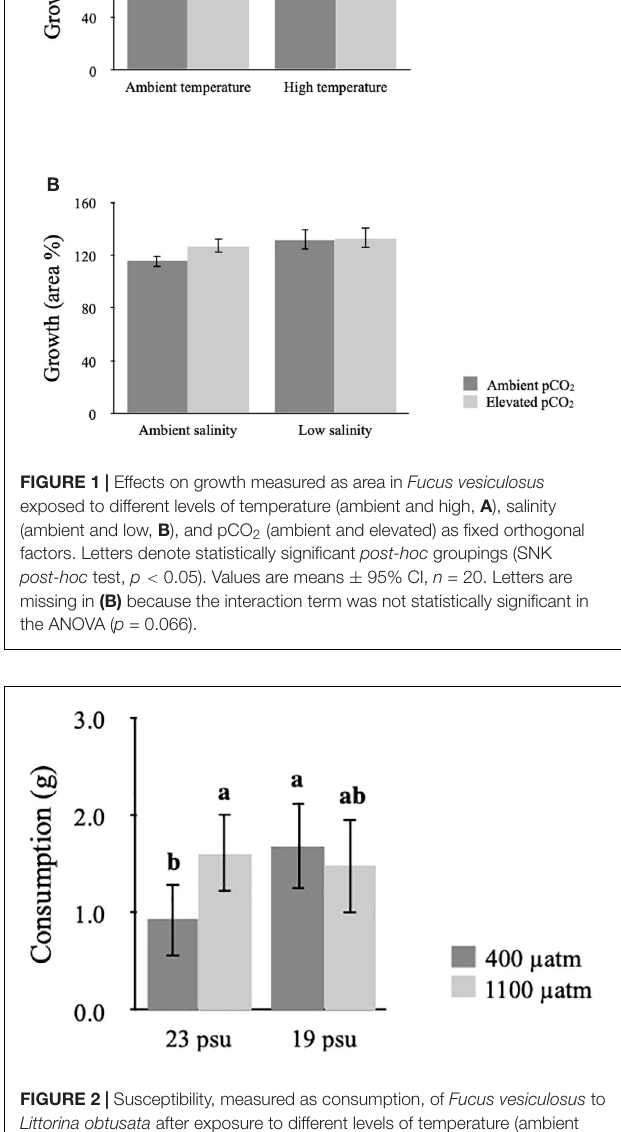
tissue to 8.0% dw ( ± 2.4, 95% CI) in grazed tissue. None